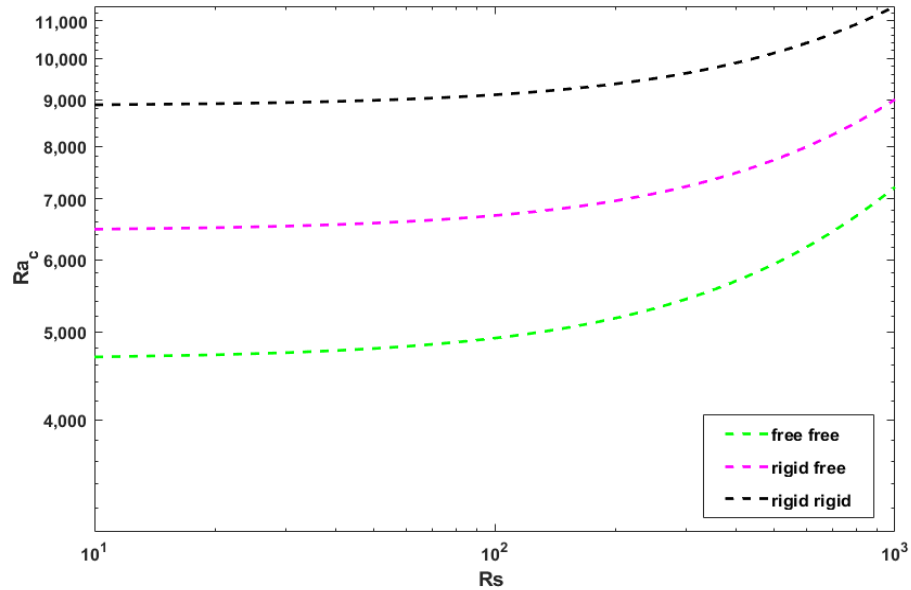
Figure 12. Effect of solutal Rayleigh number on Ra c .